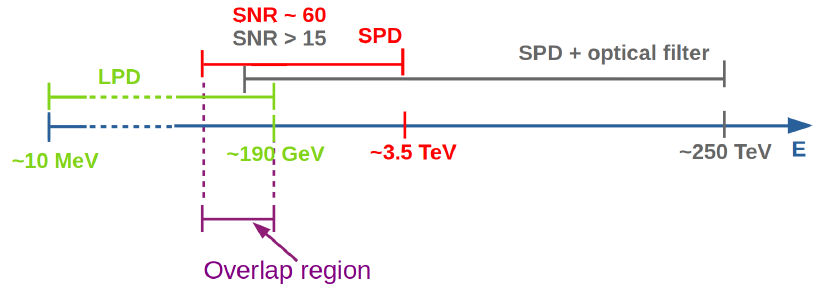
Figure 4. Scheme of the dynamic range of the system. The absolute energy scale is depicted in blue, the LPD dynamic range in green, the SPD dynamic range in red, the SPD optically filtered dynamic range in grey, and the overlapping region between LPD and SPD in